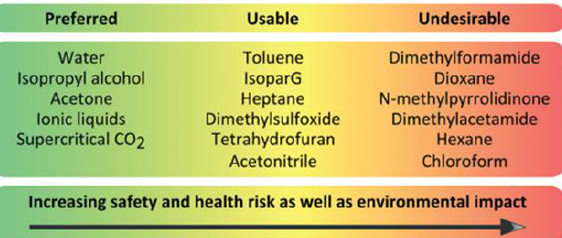
Figure 3. Strategy to develop greener membranes following the principles of green chemistry. The number next to the boxes represent the ranking in order of priority according to their contribution to making a membrane fabrication process greener. (Reprinted with permission from Ref. [95]. Copyright 2014 Royal Society of Chemistry.)